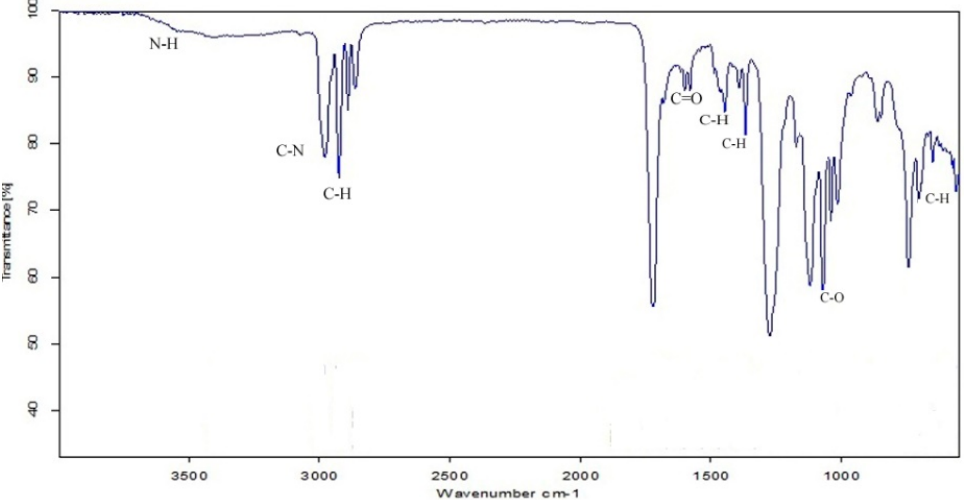
Table 4. Analysis of variance for the designed central composite design for biosurfactant production. Figure 5. IR spectrum of biosurfactant from Bacillus subtilis strain Al-Dhabi-130. Figure 5. IR spectrum of biosurfactant from Bacillus subtilis strain